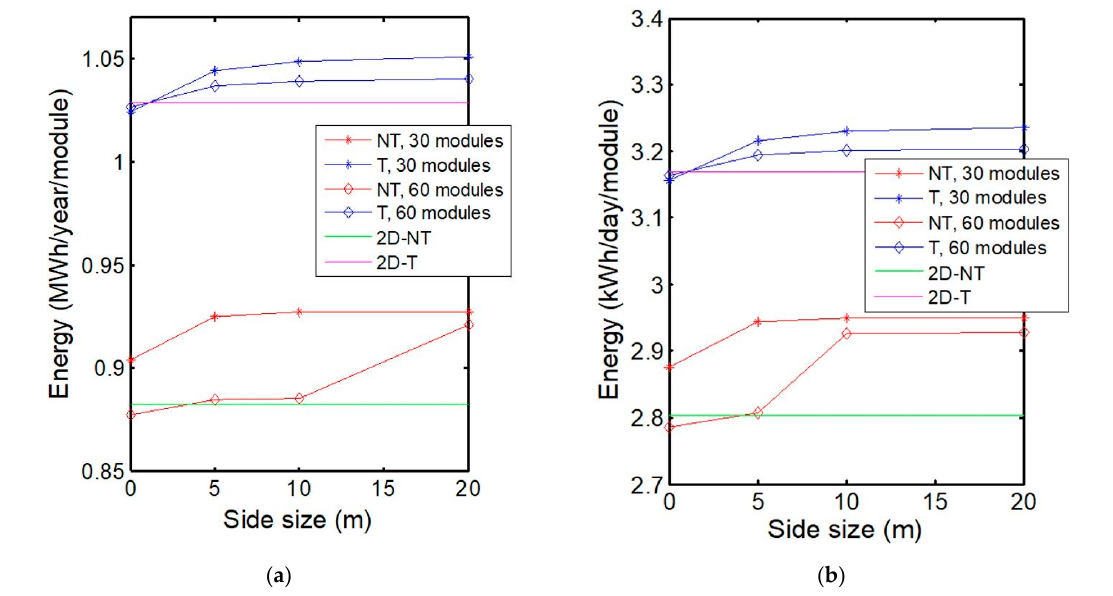
Figure 9. Perimeter effect on the energy (normalized per module) generated by the PV string, for the cases of fixed PV string (see the NT symbol in the legend, acronym of no tracker) and of PV string with uniaxial horizontal solar tracker (see the T symbol in the legend, acronym of tracker), formed by 30 or 60 modules, at the location of Catania, Italy: ( a ) specific energy per year trends, as calculated by the proposed model (considering the year 2018), and ( b ) specific energy per day trends, as calculated by considering the day n. 79 (spring equinox) of 2018. The generated energy is shown as a function of the parameter YB (for XA = 5 m) for the case of fixed string and of the parameter XA (for YB = 5 m) for the case of string with tracker. Note that the magenta and green continuous lines represent the energy values which would be estimated under the 2D approximation, i.e., the values obtained at the limit for ny → ∞ , nx = 2, YB = 0, for the case of fixed string; and for nx → ∞ , ny = 2, XA = 0, for the case of string with tracker (see the schematics of Figure 1).